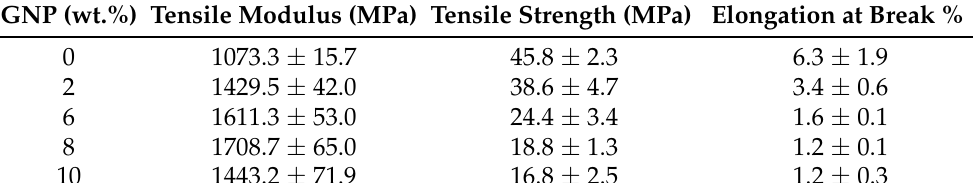
Table 1. Tensile properties of the PET-GNP nanocomposites.